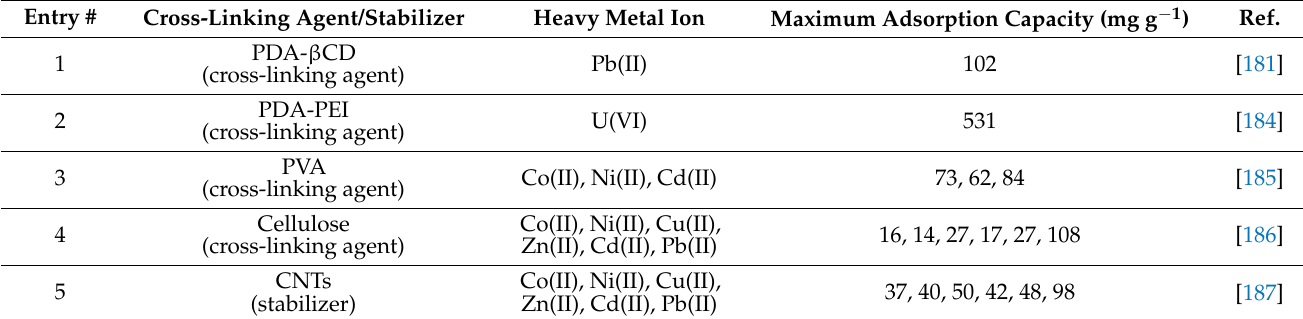
Table 6. Some examples of GO nanosheets assembled as adsorptive membranes.